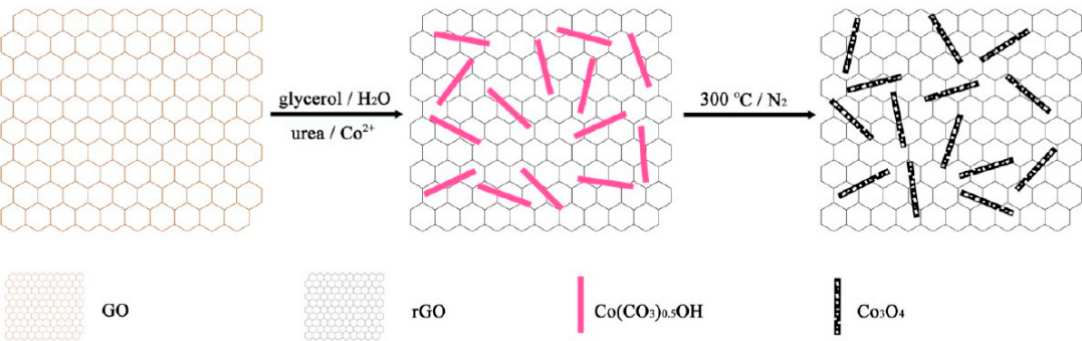
Figure 22. Procedure used in the preparation of porous Co 3 O 4 nanorod-reduced graphene oxide, PCNG. (Reprinted with permission from [191] . Copyright © 2013, American Chemical Society).